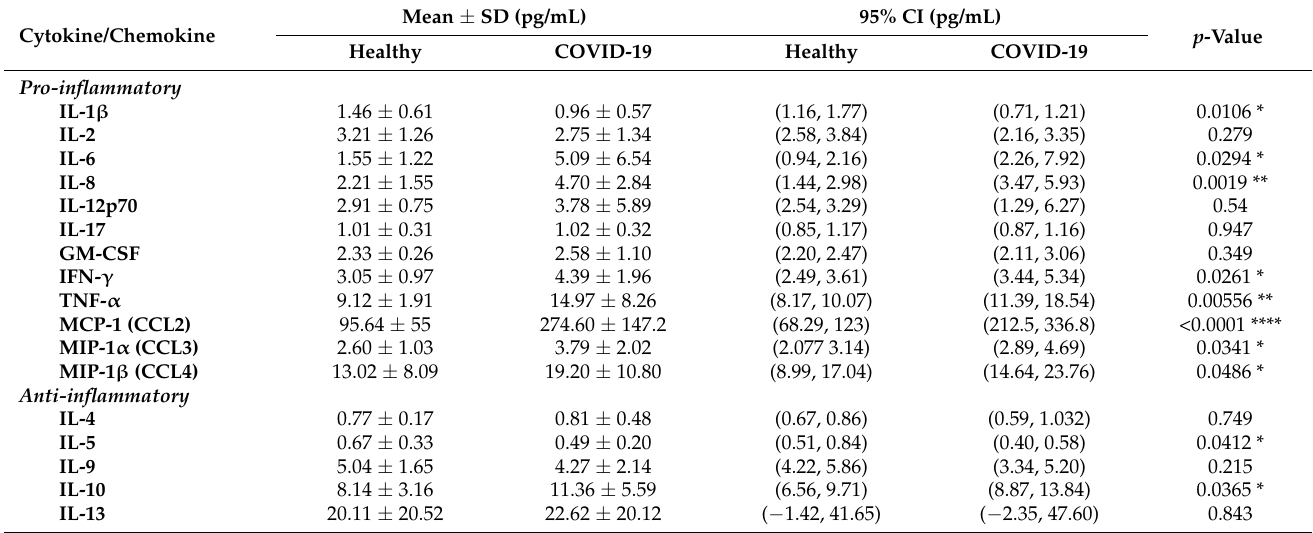
Table 5. Plasma cytokine/chemokine expression in COVID-19 and healthy subjects.